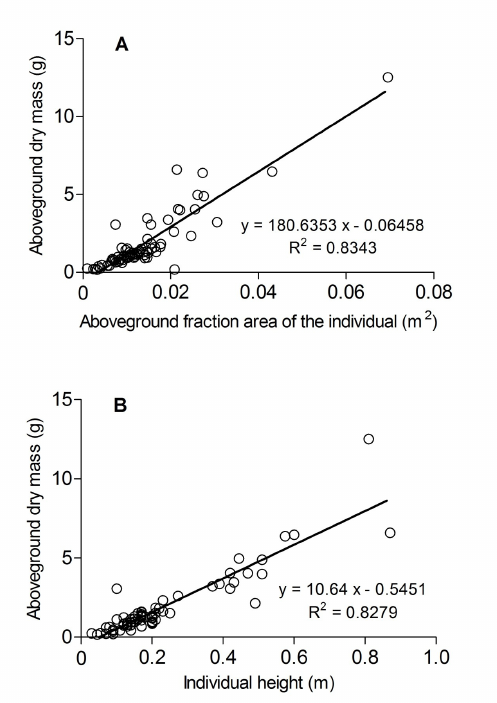
Figure 4. Simple linear regression between the individual aboveground area and aboveground dry mass (A), simple linear regression between individual height and aboveg- round dry mass (B) of Spartina alterniflora , and linear equation and coefficient of determination (R 2 ).